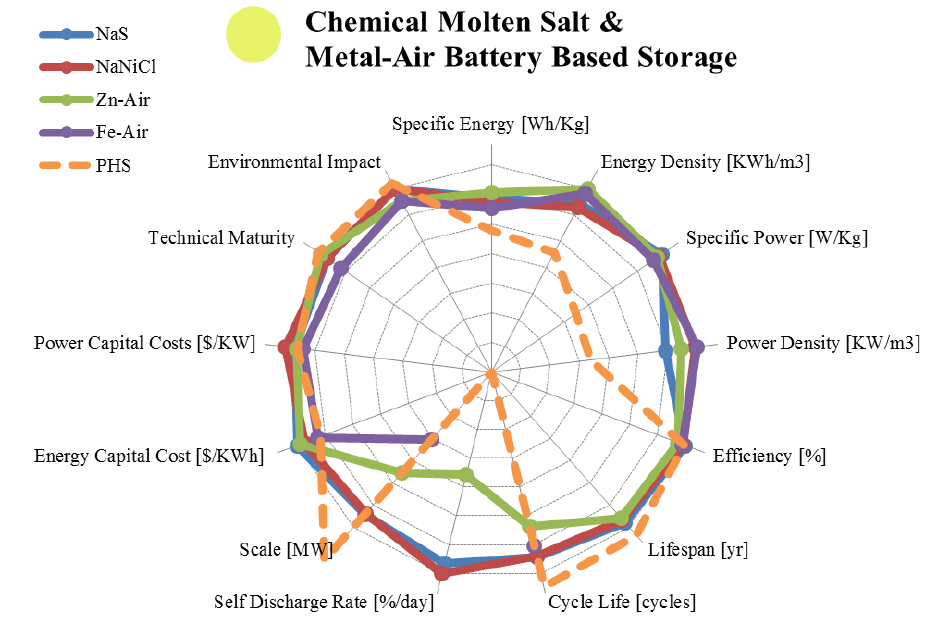
Figure 7. Comparing chemical energy storage in molten salt and metal-air batteries using normalized and logarithmically plotted average data from Table